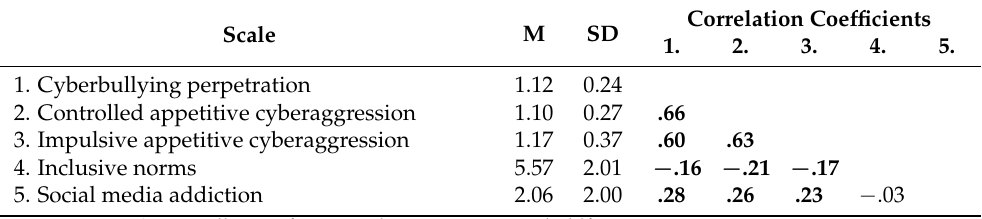
Table 1. Descriptive Statistics: Bivariate correlations, Means, and Standard Deviations.